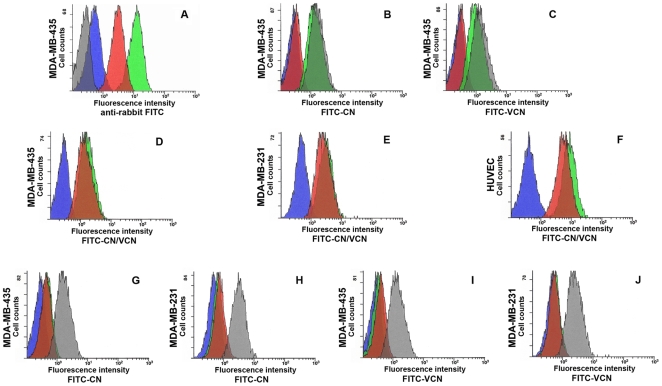
Binding analysis of FITC-labeled disintegrins by flow cytometry.
Panel A – Both CN and VCN are detected at cell surface when probed with CN polyclonal antiserum. MDA-MB-435 cells were incubated with either VCN (red) or CN (green) followed by CN rabbit polyclonal antiserum and an anti-rabbit FITC-labeled secondary antibody. The controls included cells incubated with either anti-rabbit FITC-labeled secondary only (grey) or CN antiserum followed by the FITC-labeled secondary (blue). Panels B, C
– FITC-CN (panel B) or FITC-VCN (panel C) fail to bind to cells prewashed in EDTA media, but once bound in regular media the subsequent addition of EDTA does not displace them from integrins. MDA-MB-435 cells were either incubated with FITC-labeled disintegrins only (grey) or with labeled disintegrins and then washed and resuspended in 3 mM EDTA media (green) or preincubated in 3 mM EDTA and then washed and exposed to labeled disintegrins (red) or just probed with an FITC-labeled irrelevant antibody control (blue). Panels D, E and F – Labeled disintegrins bind in a similar manner to cells with different integrin profiles. MDA-MB-435, MDA-MB-231 or HUVEC were either incubated with FITC-CN (green) or FITC-VCN (red) or probed with an FITC-labeled irrelevant antibody control (blue). Panels G, H, I and J
– FITC-labeled disintegrins fail to bind to cells pretreated with either unlabeled disintegrins or an antibody competitor. MDA-MB-435 or MDA-MB-231 cells (panels G and H) were either incubated with FITC-CN only (grey) or an FITC-labeled irrelevant antibody control only (blue) or preincubated with unlabeled VCN (green) or 7E3 (red) and then probed with FITC-CN. Similarly, MDA-MB-435 or MDA-MB-231 cells (panels I and J) were either incubated with FITC-VCN only (grey) or an FITC-labeled irrelevant antibody control only (blue) or preincubated with unlabeled CN (green) or 7E3 (red) and then probed with FITC-VCN. The data are representative of four independent experiments.